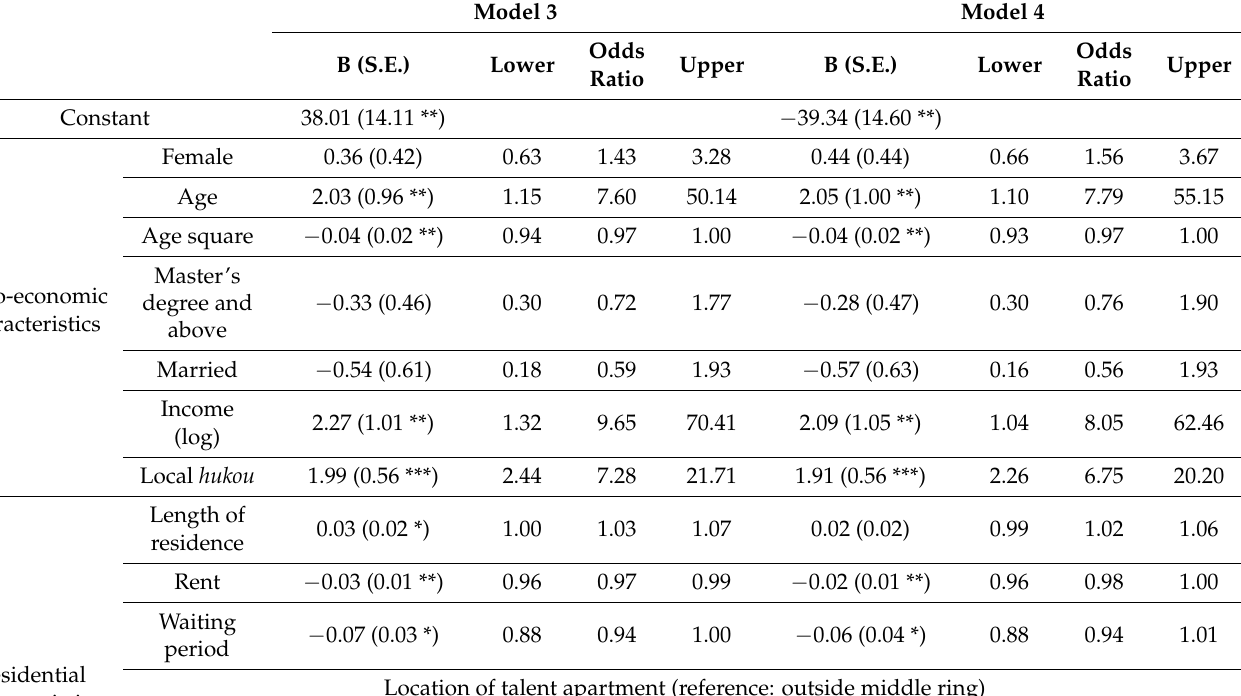
Table 5. Effects of residential plan and policy